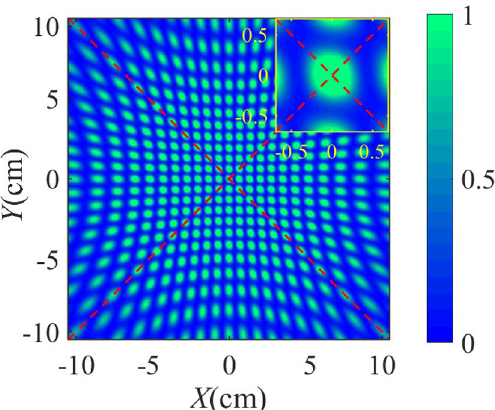
15 . 1 2 and means 0 and 2 |+ � |+ � =